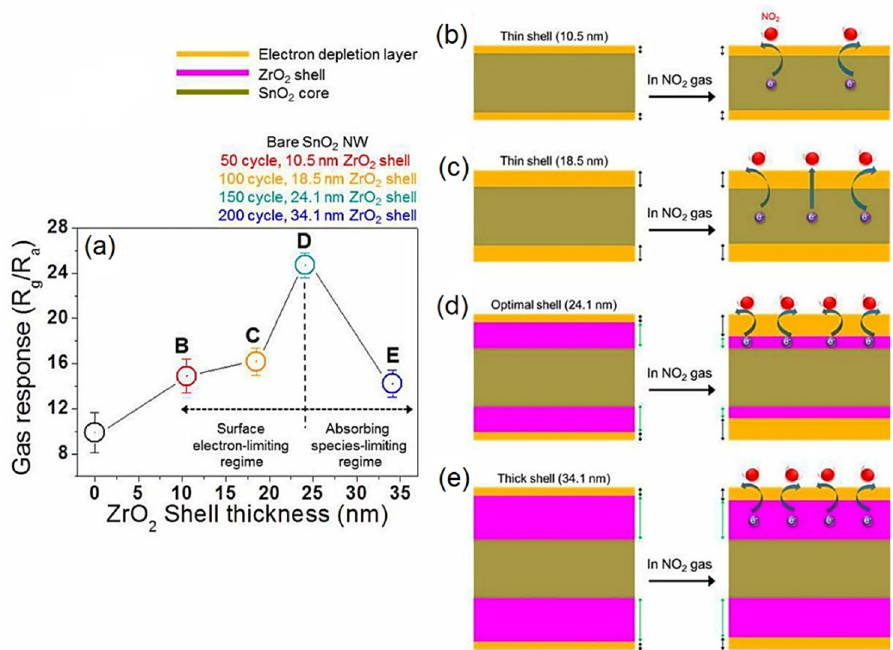
Figure 7. ( a ) NO 2 responses of SnO 2 -ZrO 2 C-S NW sensors as a function of ZrO 2 shell thickness. ( b – e ) Illustration of NO 2 sensing by the gas sensors with ZrO 2 shell thicknesses of ( b ) 10.5, ( c ) 18.5, ( d ) 24.1, and ( e ) 34.1 nm. Reproduced from [78] with the permission of Elsevier.